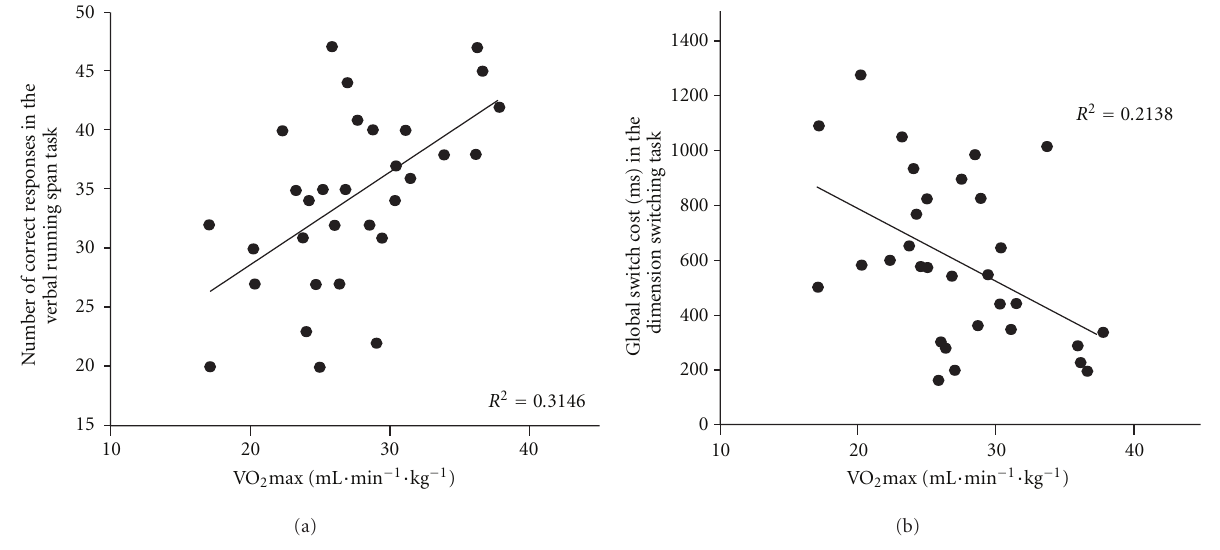
Figure 1: Scatter plots relating VO 2 max level and updating performance of verbal information (a) and global switch cost (b) in the older